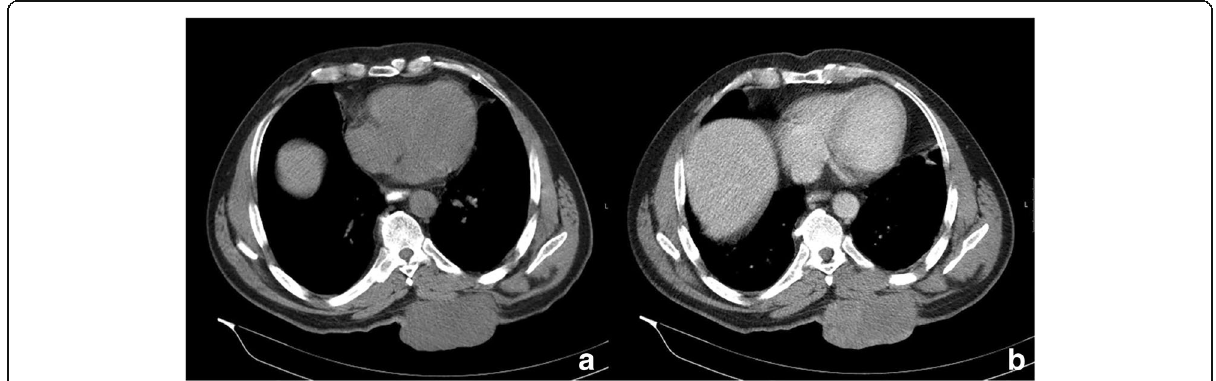
Fig. 1 Dorsal thoracic SFT in man, 55 years. Axial unenhanced ( a ) and enhanced ( b ) CT shows a homogeneous lobular enhancing mass in the left posterior thoracic wall with smooth well-defined margins. This patient was submited to resection with no evidence of recurrence to date